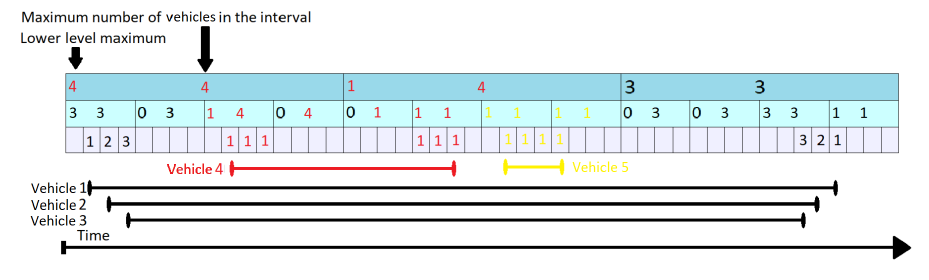
Figure 9. KI Tree Update for Vehicle 5.